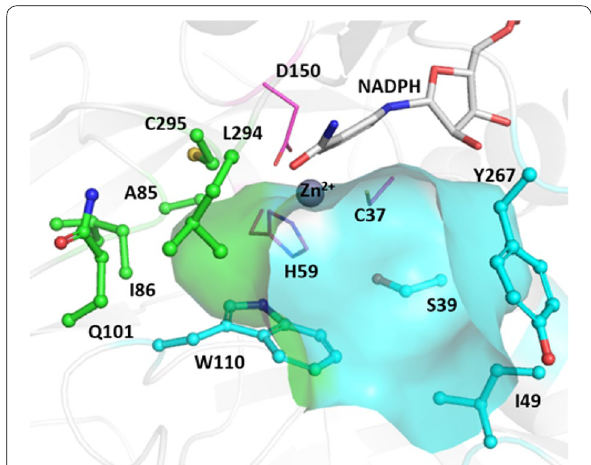
Fig. 1 The overall structure of the TbSADH catalytic pocket (PDB code 1YKF), consisting of a smaller (green) and a bigger (cyan) pockets. NADPH is shown by white sticks, whereas Zinc atom is depicted by a gray sphere. The zinc-coordinating residues are colored in magenta and are presented in